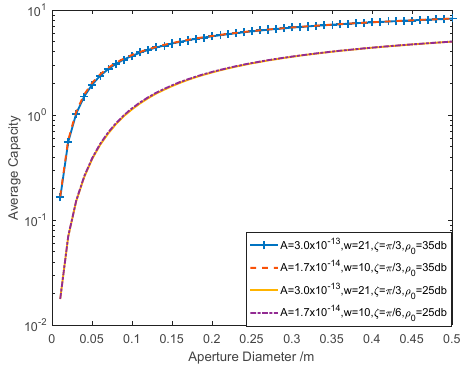
Figure 5. Performance of average capacity when the aperture area is variable.